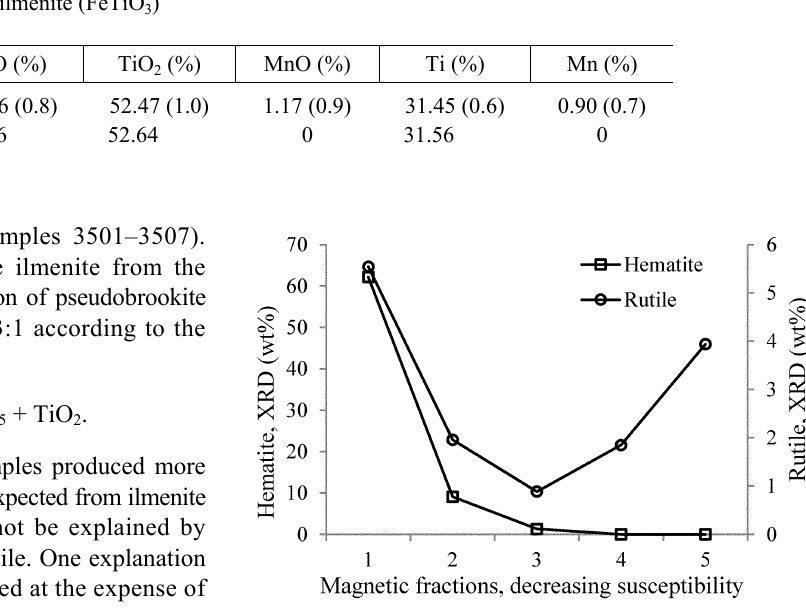
Fig. 6. Contents of rutile and hematite in different magnetic fractions for mixed samples 3501–3507 with a grain size of 0.05–0.1 mm. The magnetic fractions are named after dominant minerals: (1) hematite, (2) ilmenite, (3) garnets, (4) amphiboles and (5) zircon.